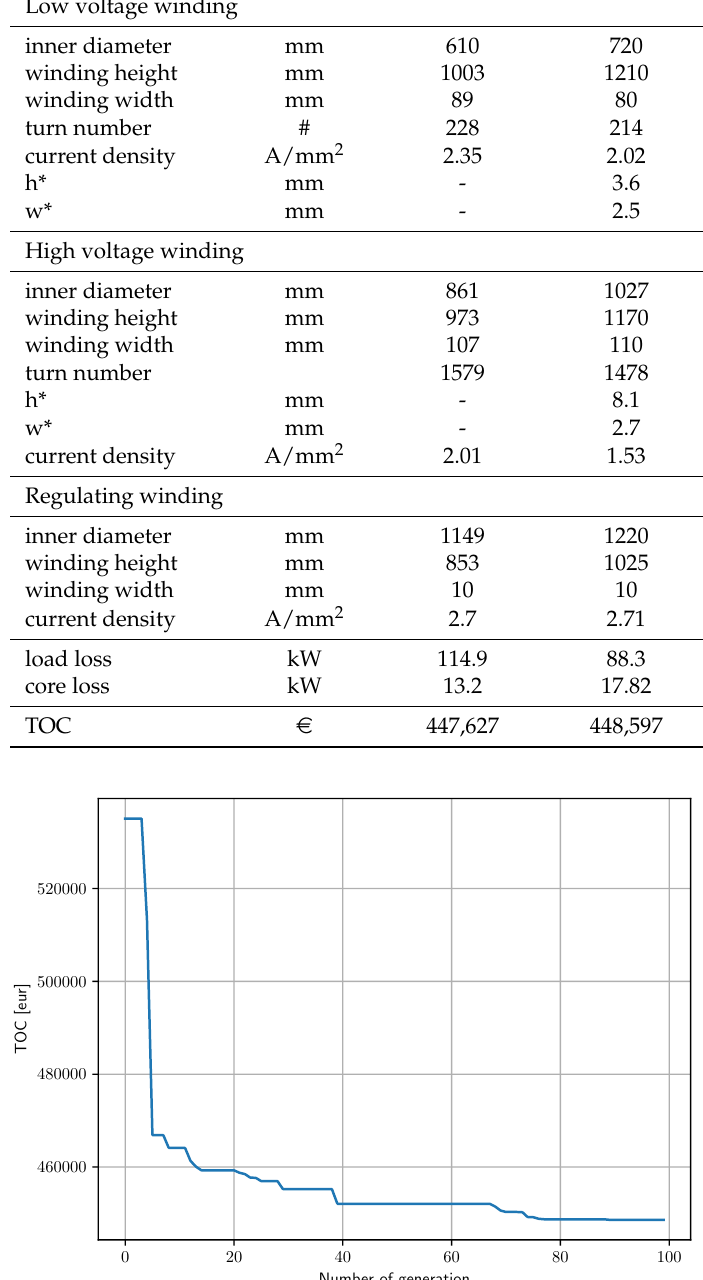
Figure 7. Evolution of the TOC during the optimization